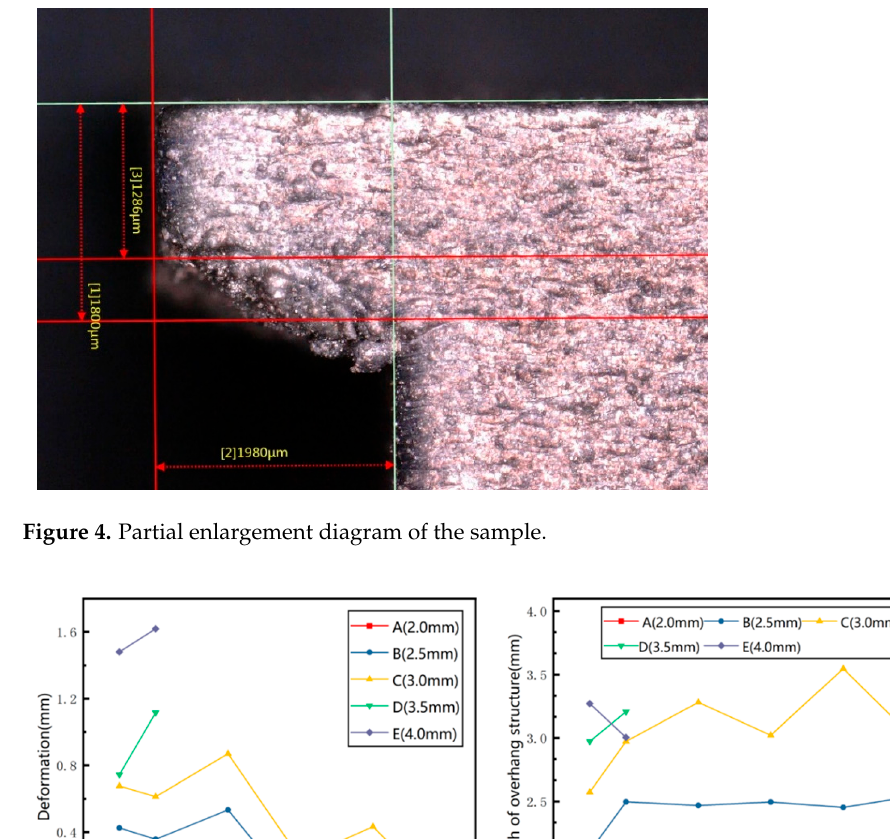
Figure 4. Partial enlargement diagram of the sample.